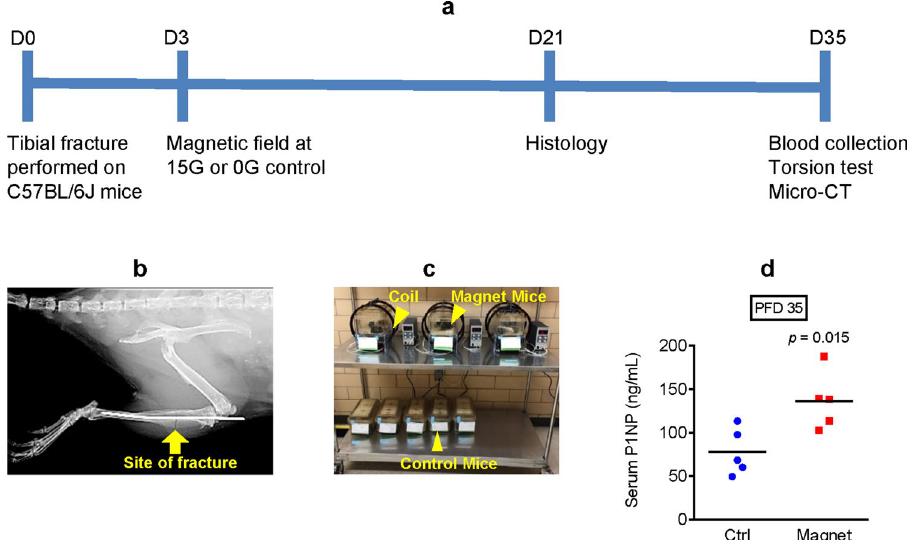
Figure 3. Electromagnetic field stimulation promotes bone formation during mouse tibial fracture repair. ( a ) Diagram outlining the experimental setup; ( b ) X-Ray image of tibia that underwent fracture with intramedullary pin inserted; ( c ) Picture of mice exposed and not exposed to the electromagnetic field; ( d ) Serum bone formation marker propeptide of type I procollagen (P1NP) was measured via ELISA on post-fracture day (PFD) 35. Plot shows actual data points and calculated means. P value was determined via the t